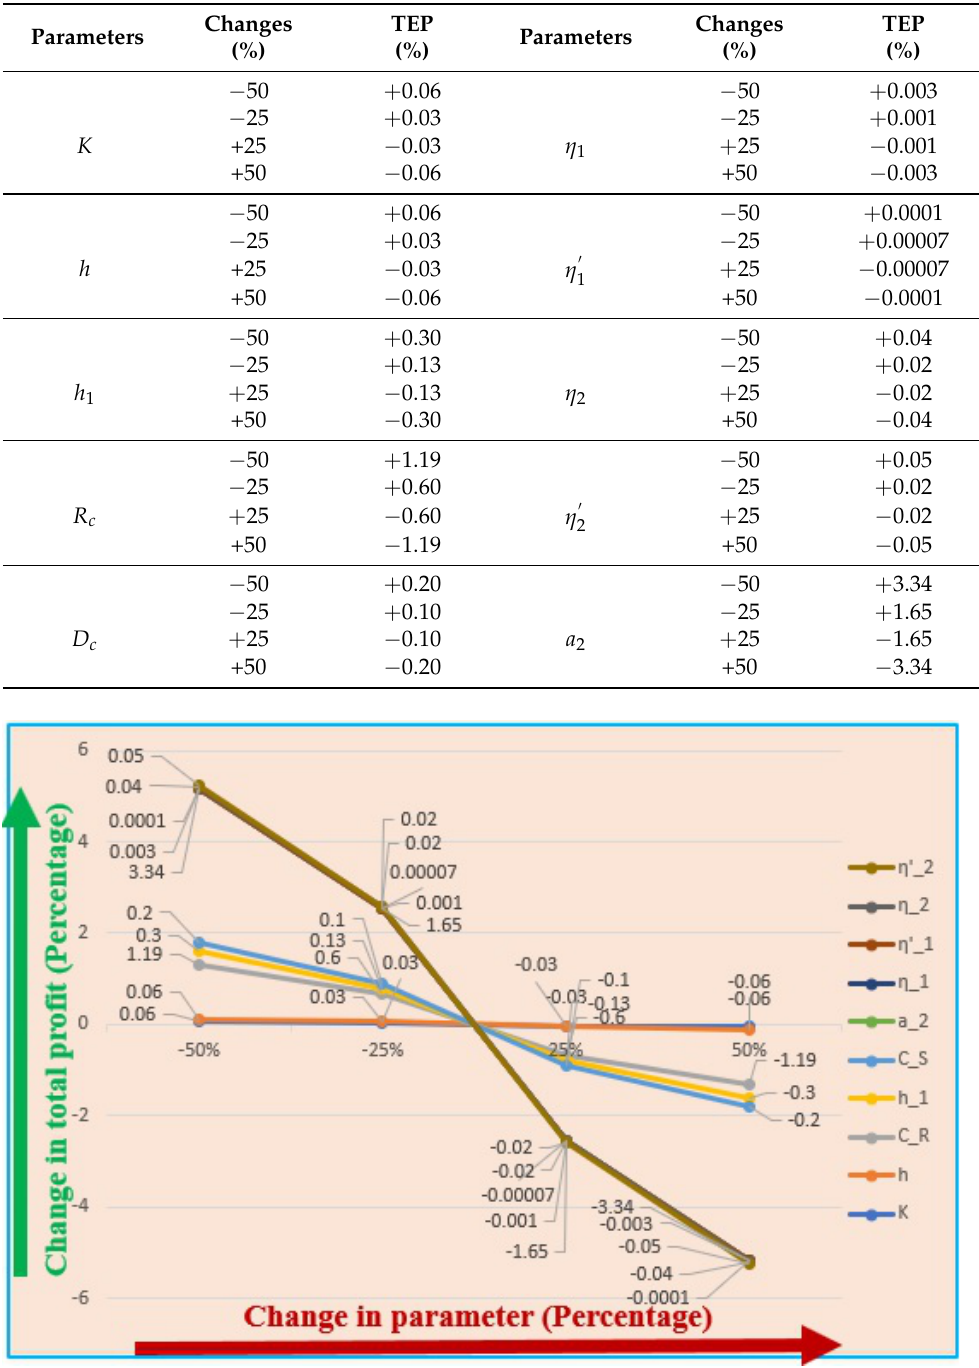
Table 8. Sensitivity analysis of key parameters of Example 1.